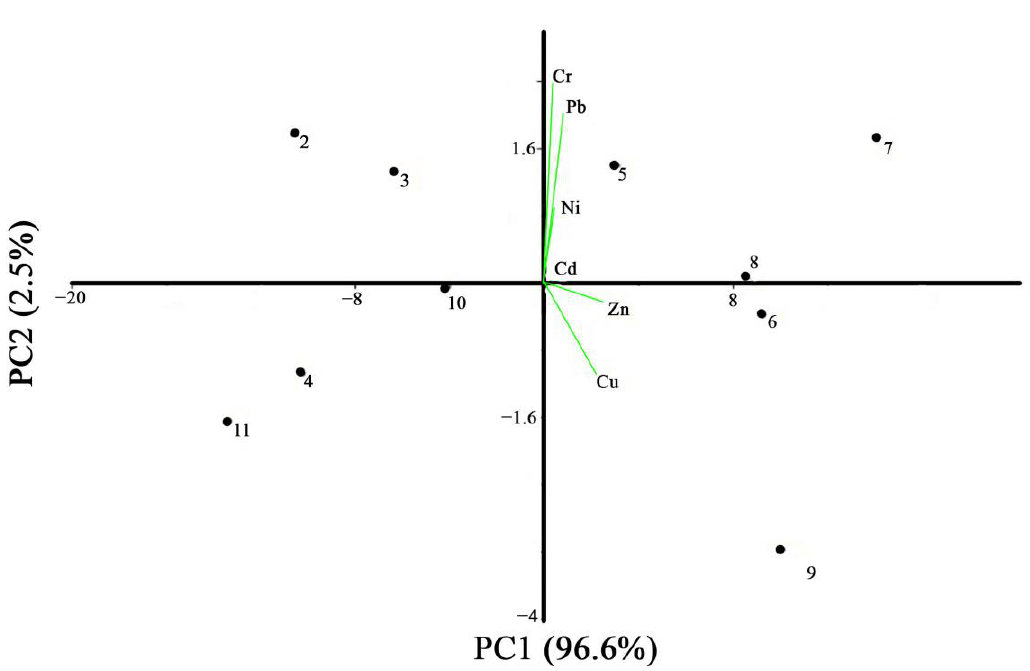
Table 4. Spearmen’s correlation of the studied trace metals.